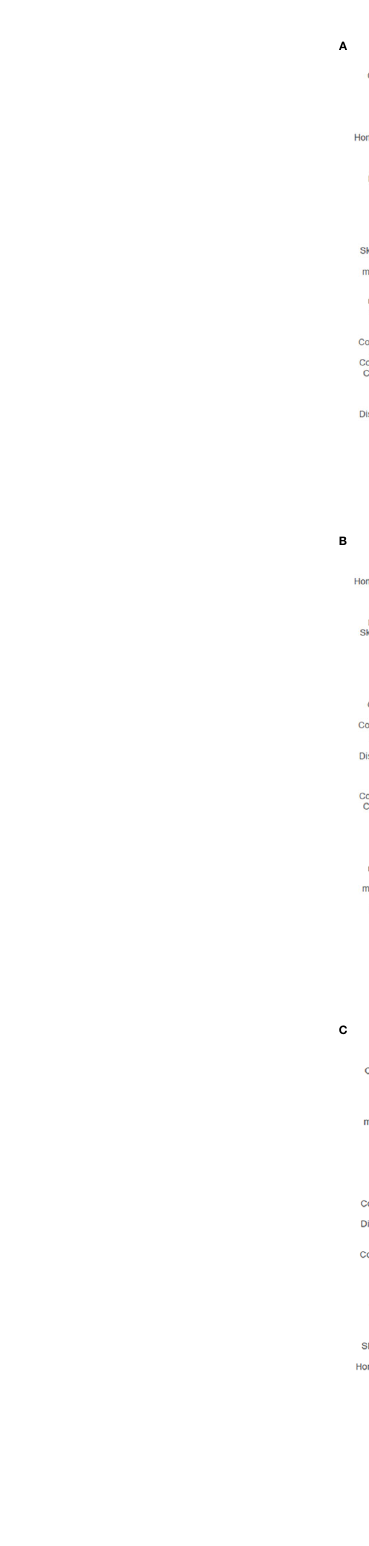
FIGURE 2 | Graphs showing in fl uence of software resampling step on phantom study. Each graph representes the two-by-two coef fi cient correlation calculation between the texture parameters at one resampling level. The difference in resulting patterns shows the in fl uence of the software resampling step on texture parameters calculation, particularly on parameters extracted from co occurrence matrix. (A) 256 gray levels resampling. (B) 128 gray levels resampling. (C) 64 gray levels